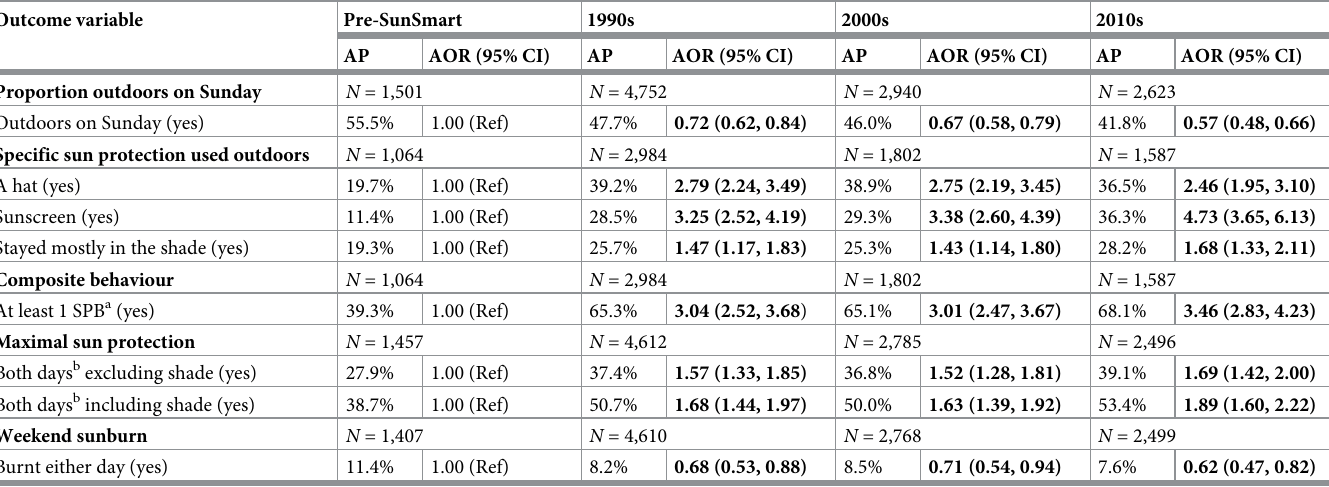
Table 3. Sun exposure and sun protection use among Melbourne residents by decade, relative to before the SunSmart program. Outcome